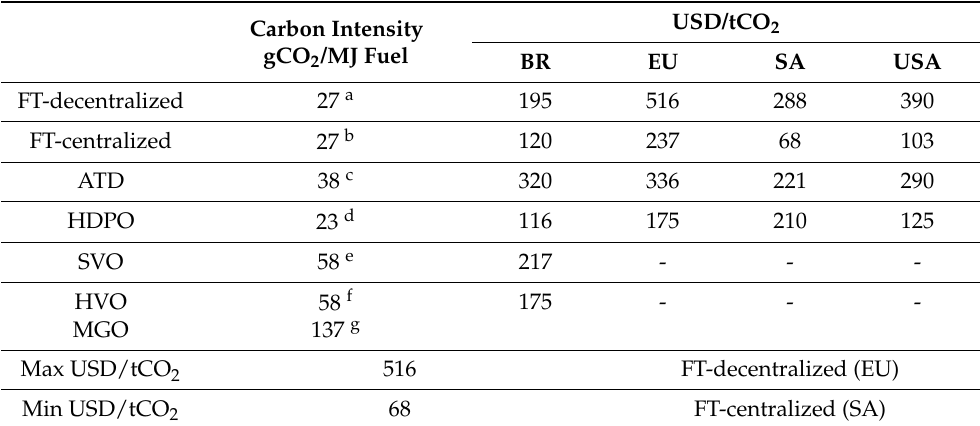
Table 5. Carbon prices required for biobunkers competitiveness. Notes: a Average literature values for different world regions, b [28,95,96], c [62,97–99], d [100–102], e [2,103], f [28,96,104], g